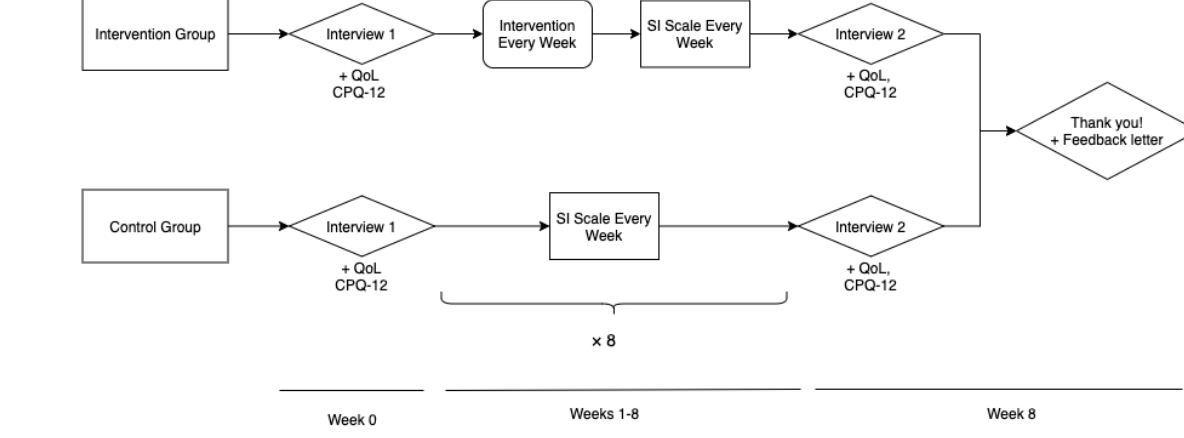
Figure 1. Diagram detailing the timeline for the study components. QoL: quality of life; CPQ-12: Computer Proficiency Questionnaire-12; SI scale: social isolation scales (Center for Epidemiologic Studies Depression Scale and University of California, Los Angeles Loneliness Scale version